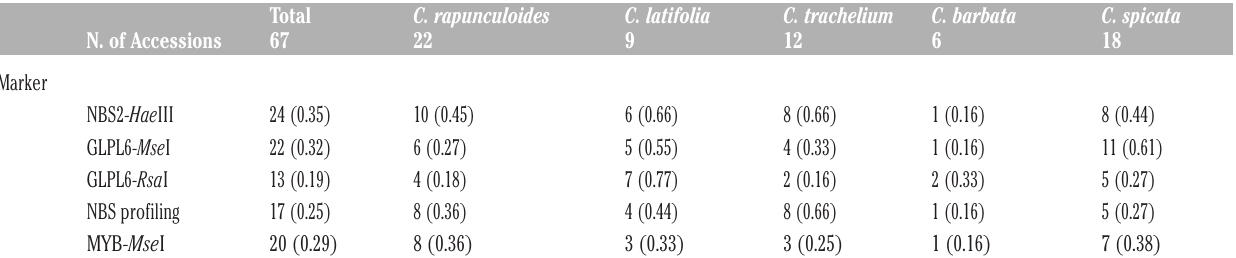
Table 2. Number of unique banding patterns in the studied Campanula species obtained by means of myb and NBS primer-enzyme combinations. In brackets, the percentage of unique banding patterns per species is reported. Total Marker GLPL6- Mse I